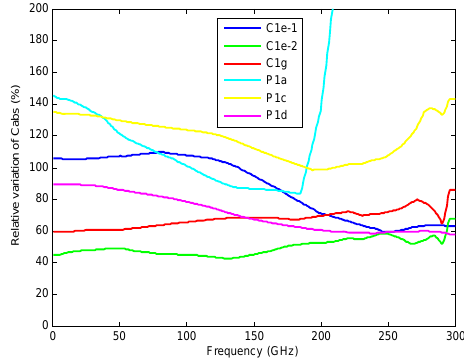
Fig. 8. Relative variation of Cabs of ice crystals (averaged orientation) compared to an equal volume sphere.